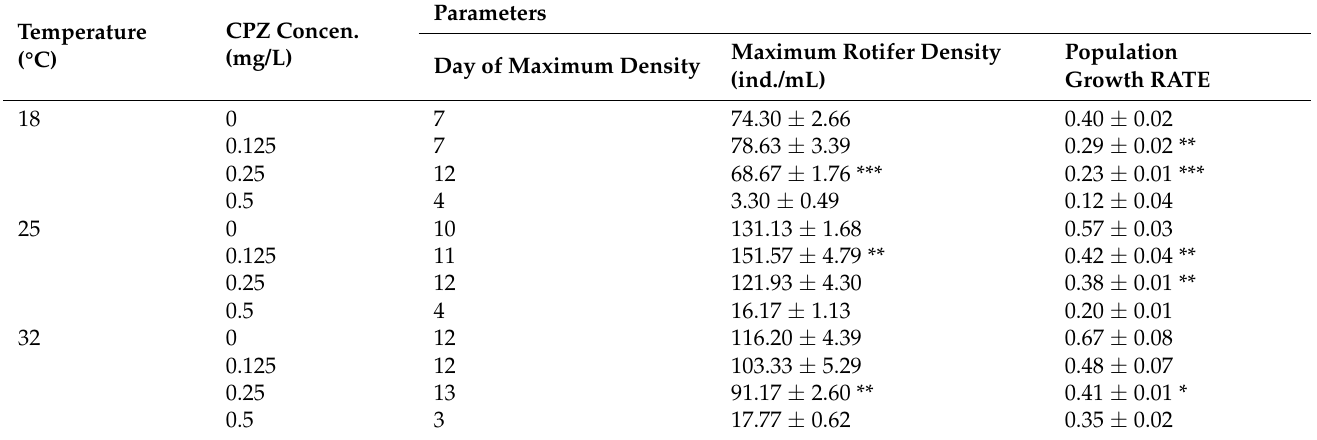
Table 4. Population parameters of B. calyciflorus to three concentrations of chlorpromazine at different temperatures. Shown are the mean ± standard error based on three